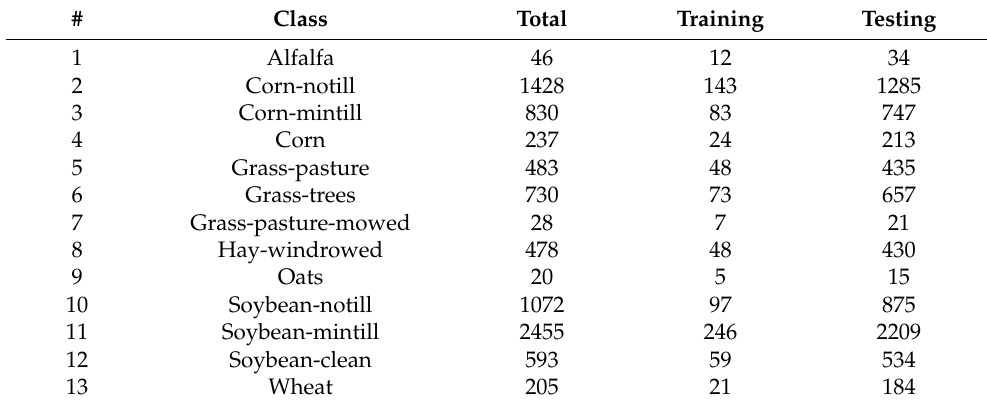
Table 1. The numbers of total, training, and testing samples for the Indian Pines